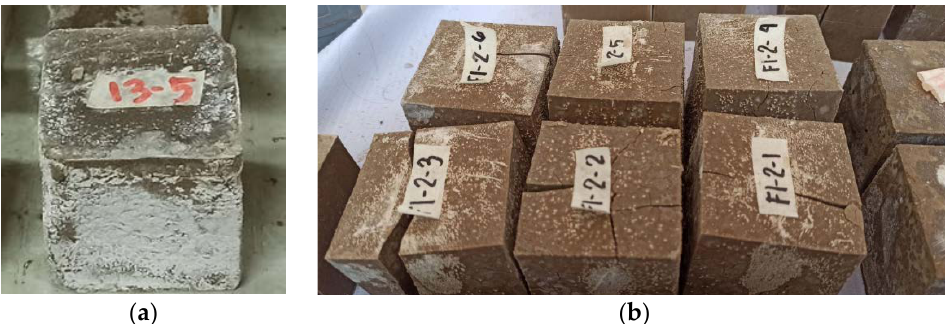
Figure 5. ( a ) Sample of a specimen that exhibits efflorescence. ( b ) Specimens that exhibit efflorescence and cracked before testing.